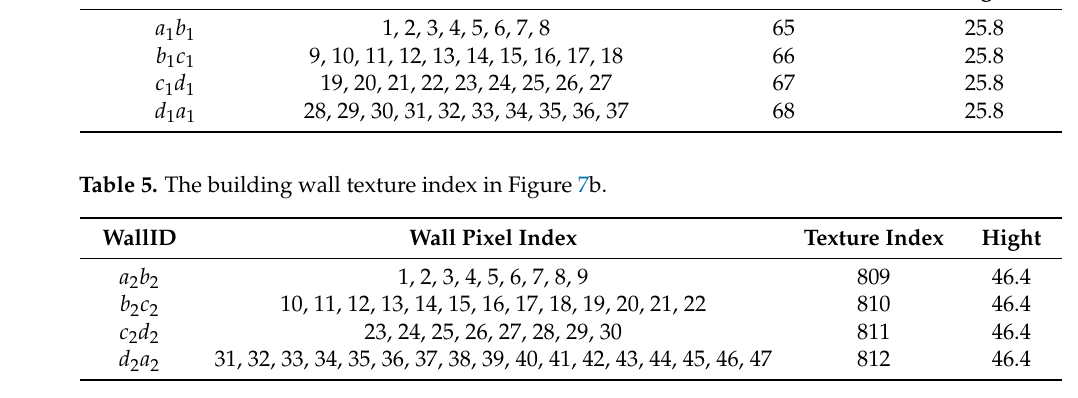
Table 4. The building wall texture index in Figure 7a.